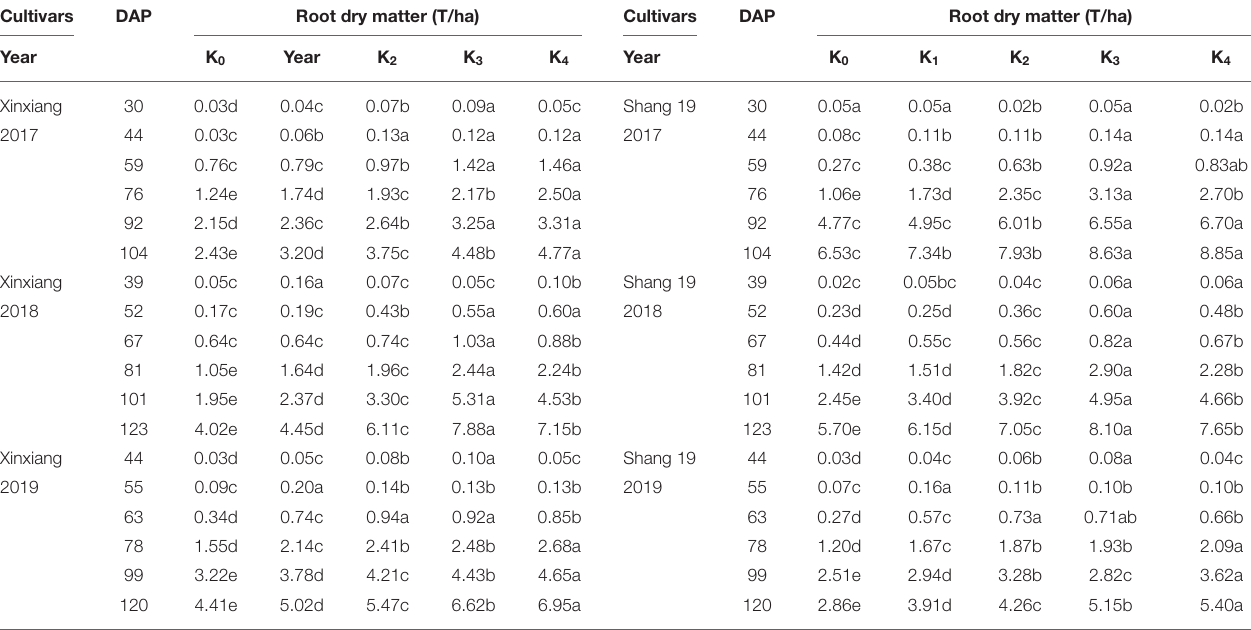
TABLE 2 | Root dry matter for sweet potato grown under different potassium (K) application rates in three field experiments.